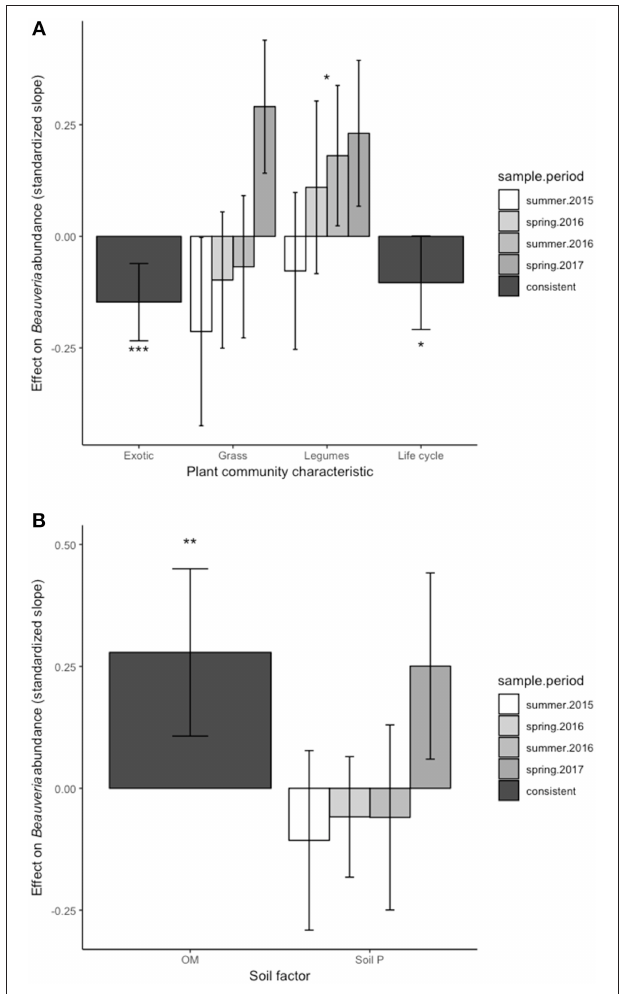
FIGURE 1 | Effect of plant community characteristics (A) and soil properties (B) on Beauveria bassisana abundance. Positive values indicate a positive relationship (standardized slope) between a given factor and B.bassiana at that sampling point while negative values represent a negative relationship. A single bar for a given factor means that sampling time did not change the relationship between B. bassiana and that factor, i.e., effects were consistent across time. The presence of bars for each sampling time indicates that the relationship between B. bassiana and a given factor depended on sampling time. Height of the bar indicates relative strength of each effect. Error bars represent 95% confidence limits. Error bars that do not cross 0 on the y-axis indicate significantly positive or negative relationships between soil factors and B. bassiana abundance at a given sample period. “*,” “**,” and “***” indicate overall significant ( P < 0.05, 0.01, and 0.001, respectively) positive or negative effects of a factor on B. bassiana abundance.